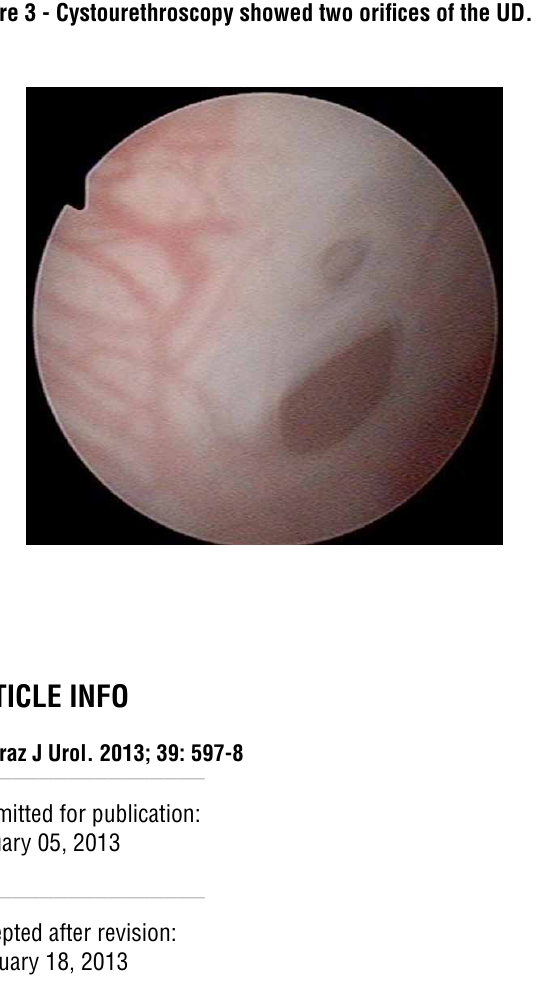
Figure 3 - Cystourethroscopy showed two orifices of the uD.